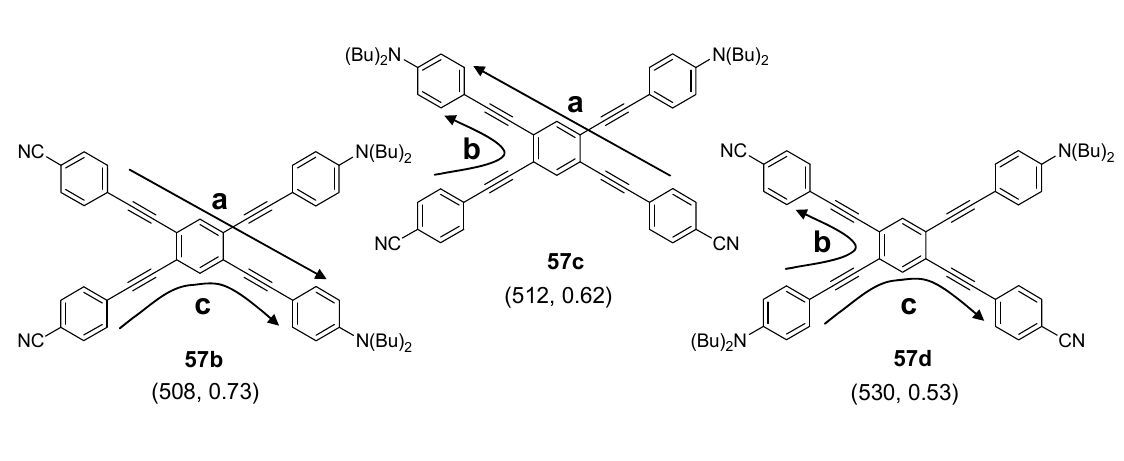
Figure 18. Conjugation paths in donor-acceptor substituted cross-shaped stars 57 (emission maxima [nm], quantum yield Φ